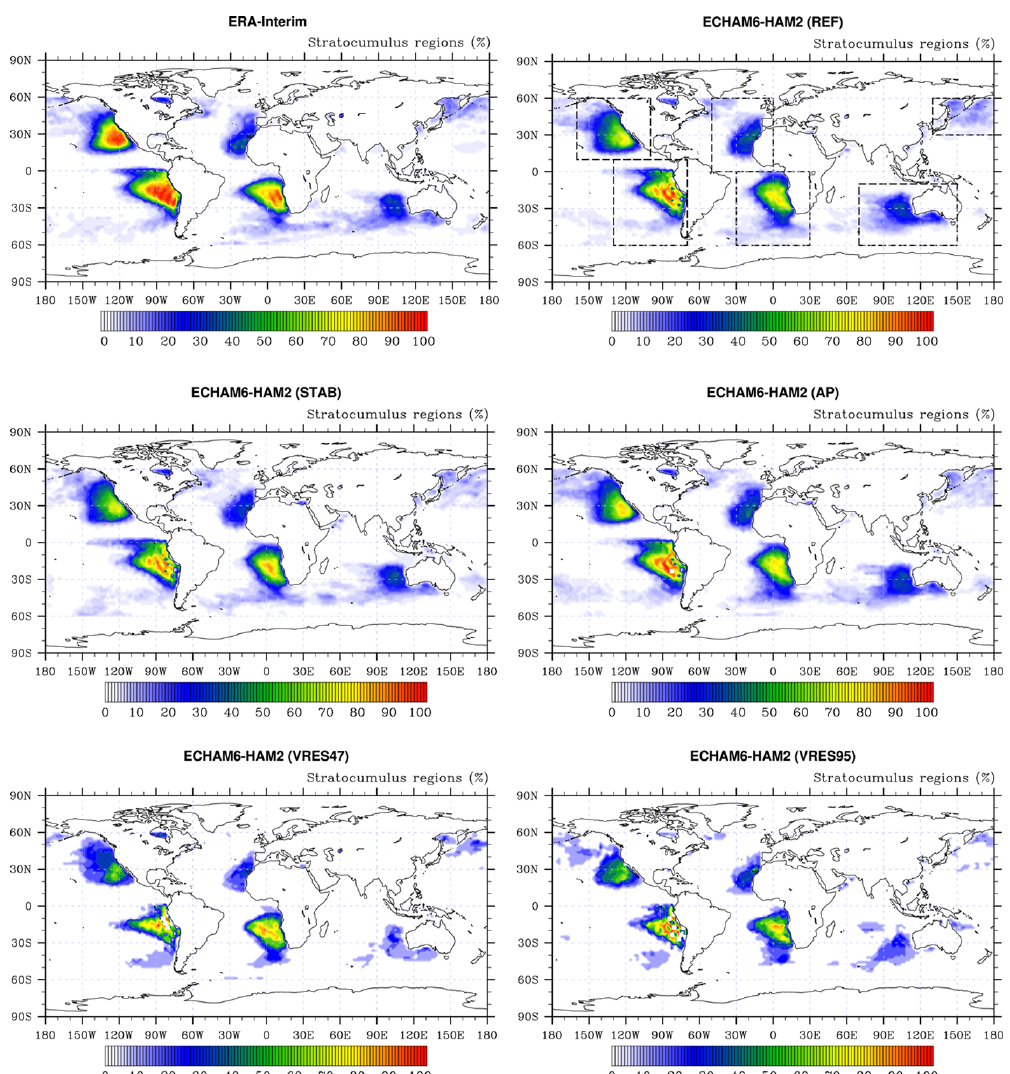
Figure 4. Frequency of occurrence of stratocumulus conditions in ERA-Interim and ECHAM6-HAM2 in the REF, STAB, AP, VRES47 and VRES95 experiments. In the panel for the REF experiment, the six stratocumulus regions which are used in assessing the effect of anthropogenic aerosol are also